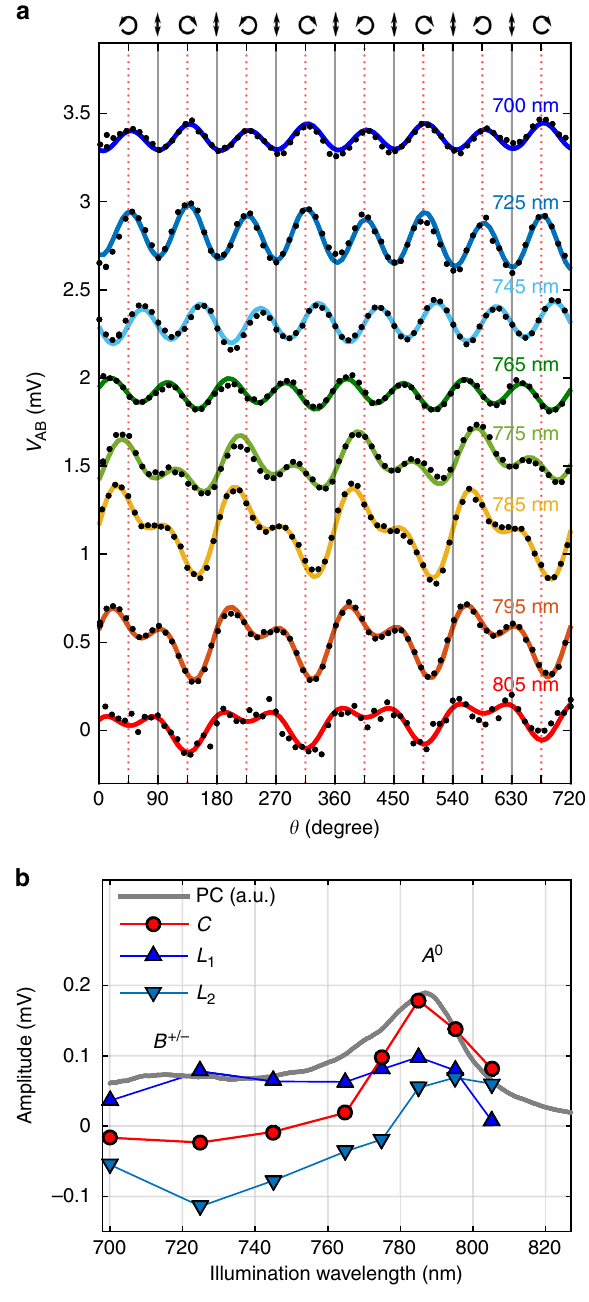
Fig. 2 Spectral evolution of the circular photocurrent. a V AB as a function of the waveplate angle, θ (for ϕ = 20°, V ds,12 = 0, V gate = 0 and α = 45°) under different illumination wavelengths, from 700 nm to 825 nm. For clarity, the traces have been vertically shifted in steps of 0.5 mV. The solid lines are fi ts to Equation 1. b Photocurrent spectrum of the 1L-MoSe 2 crystal (grey, solid line) and spectral dependence of the fi tting parameters C , L 1 and L 2 (red, dark blue and pale blue lines, see